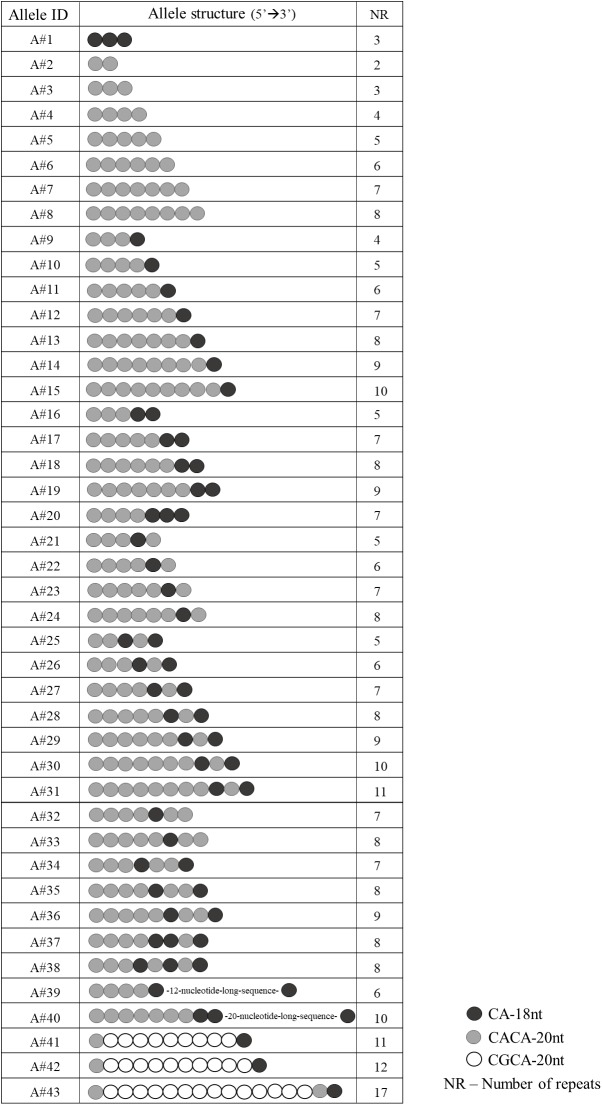
Schematic representation of the 43 allele structures identified in the 380 unaffected individuals.